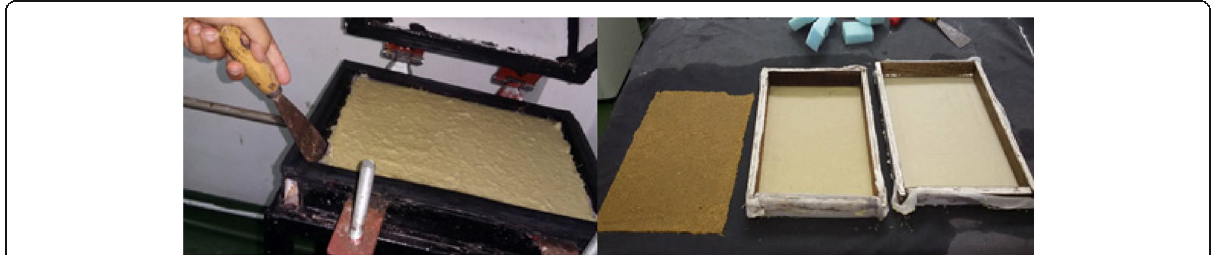
Fig. 2 Lifting of mould by a blunt putty knife and placed on felt